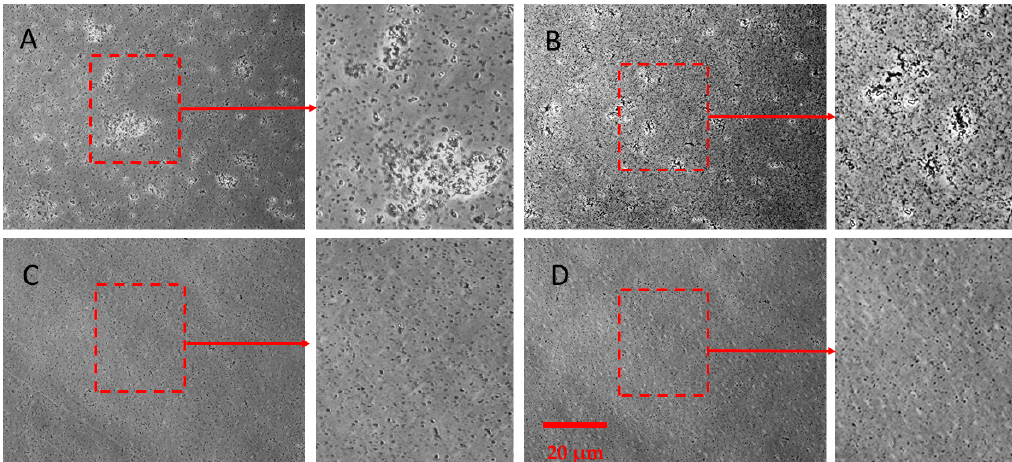
Figure 7. Phase-contrast microscopy images showing morphology of P. aeruginosa PAO1 grown in the presence of ( A ) control/untreated; ( B ) Dimethyl sulfoxide (DMSO) only; ( C ) 400 μ M 13e; ( D ) 400 μ M13d. Scale bar = 20 μ m